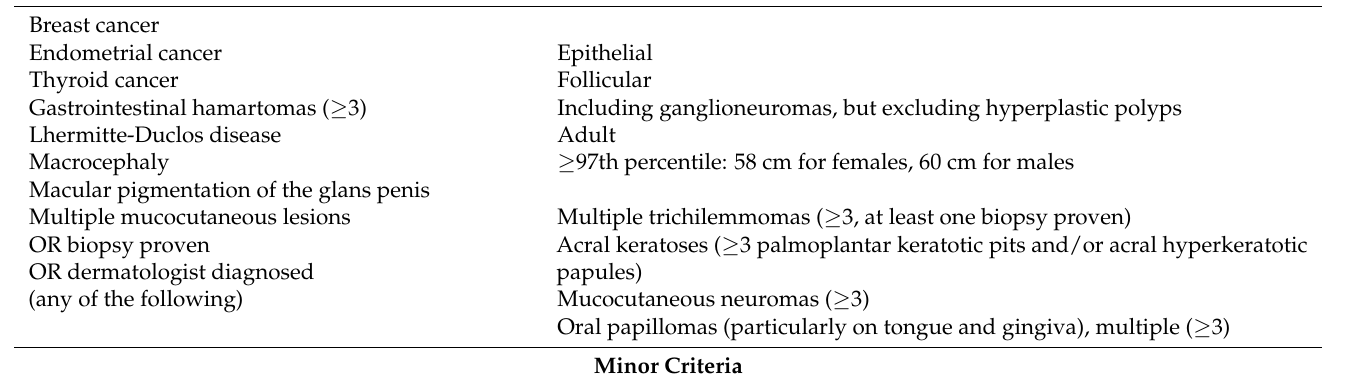
Table 2. PTEN hamartoma tumor syndrome clinical diagnostic criteria. Major